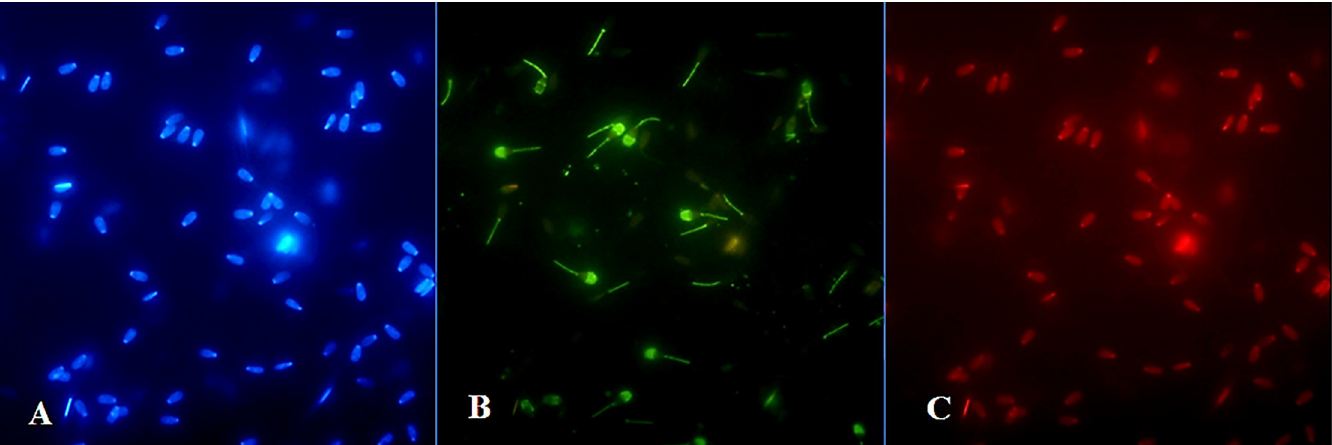
Fig 5. In vitro culture of spermatozoa with the highest concentration (1000 μ M) of FeSO 4 .7H 2 O after Time 6 h. Blue-stained (DAPI positive) chromatin of spermatozoa heads (A). Typical apoptotic (B) as well as necrotic spermatozoa alterations (C), fluorescently detected by propidium iodide (red staining) (400x magnification).